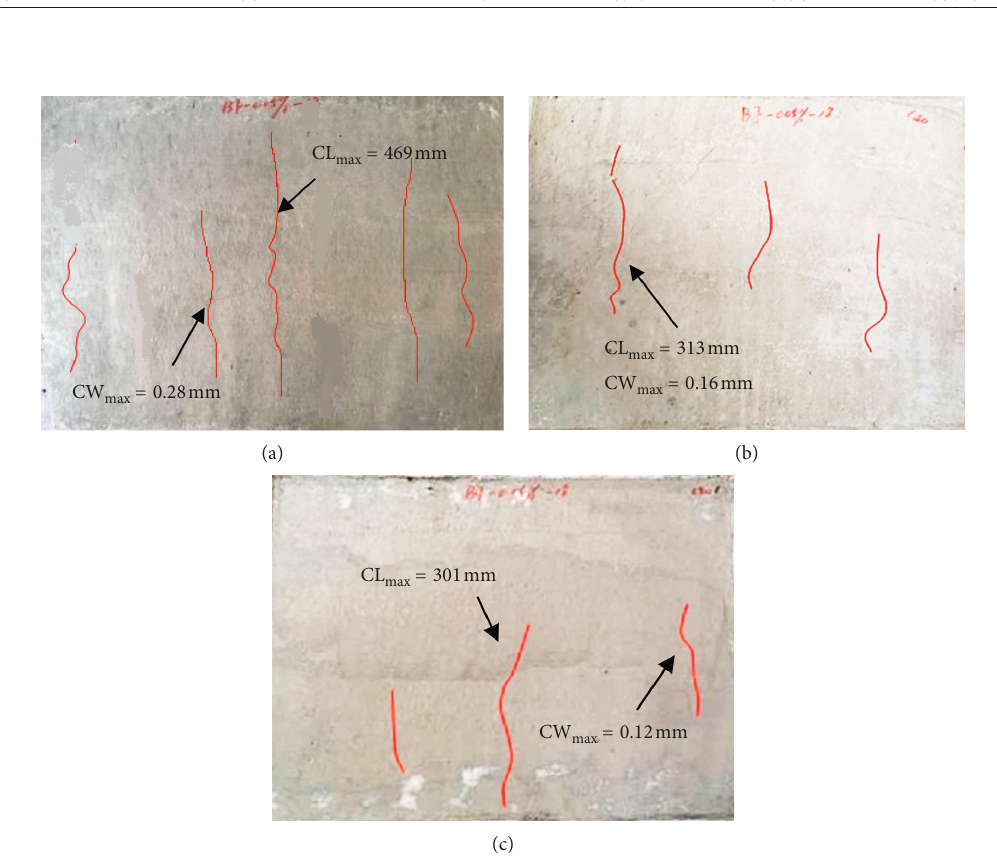
Figure 15: Crack distributions of different specimens with different compressive strength values: (a) BF 30-18-0.05, (b) BF 40-18-0.05, and (c) BF